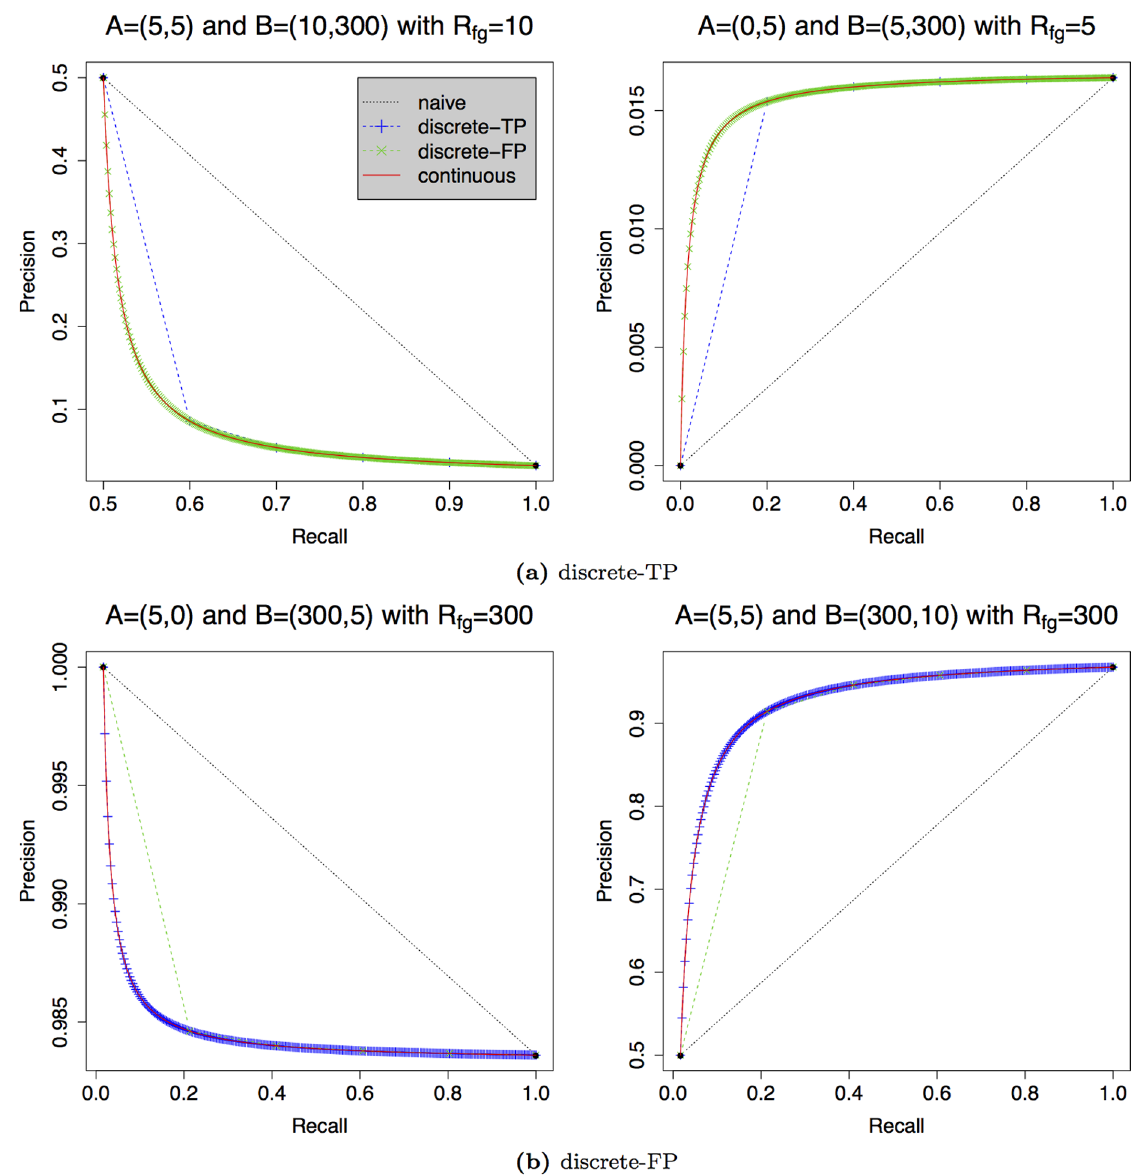
Figure 2. Differences between discrete and the continuous interpolations of the PR curve. The figure shows for each discrete interpolation (along true positives or along false positives) one example of a larger and smaller AUC between two supporting